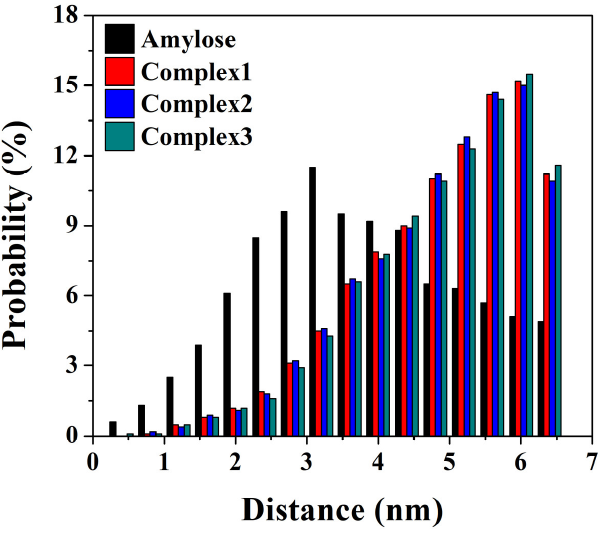
Figure 4. The probability distribution of the distances of two ends of amylose molecule in both the single-strand system (black bars) and three amylose–zein complexes with different initial values (red, blue and green bars).